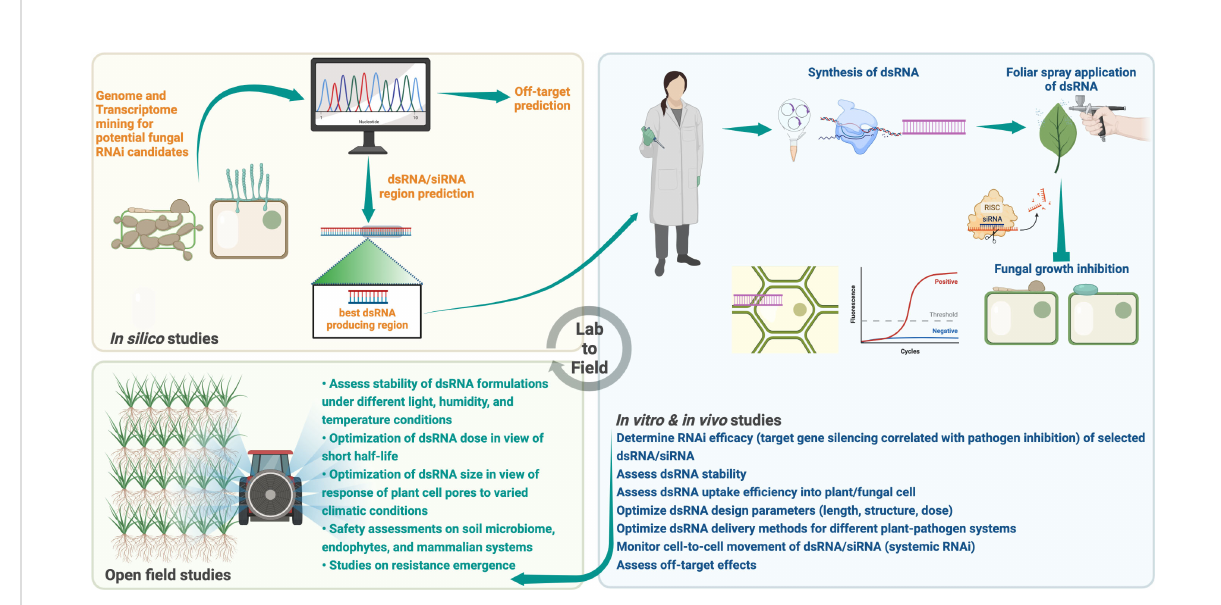
FIGURE 2 A checklist of experiments to consider for successful RNAi against phytopathogenic fungi and the development of innovative RNA-based fungicides for practical applications. Created with